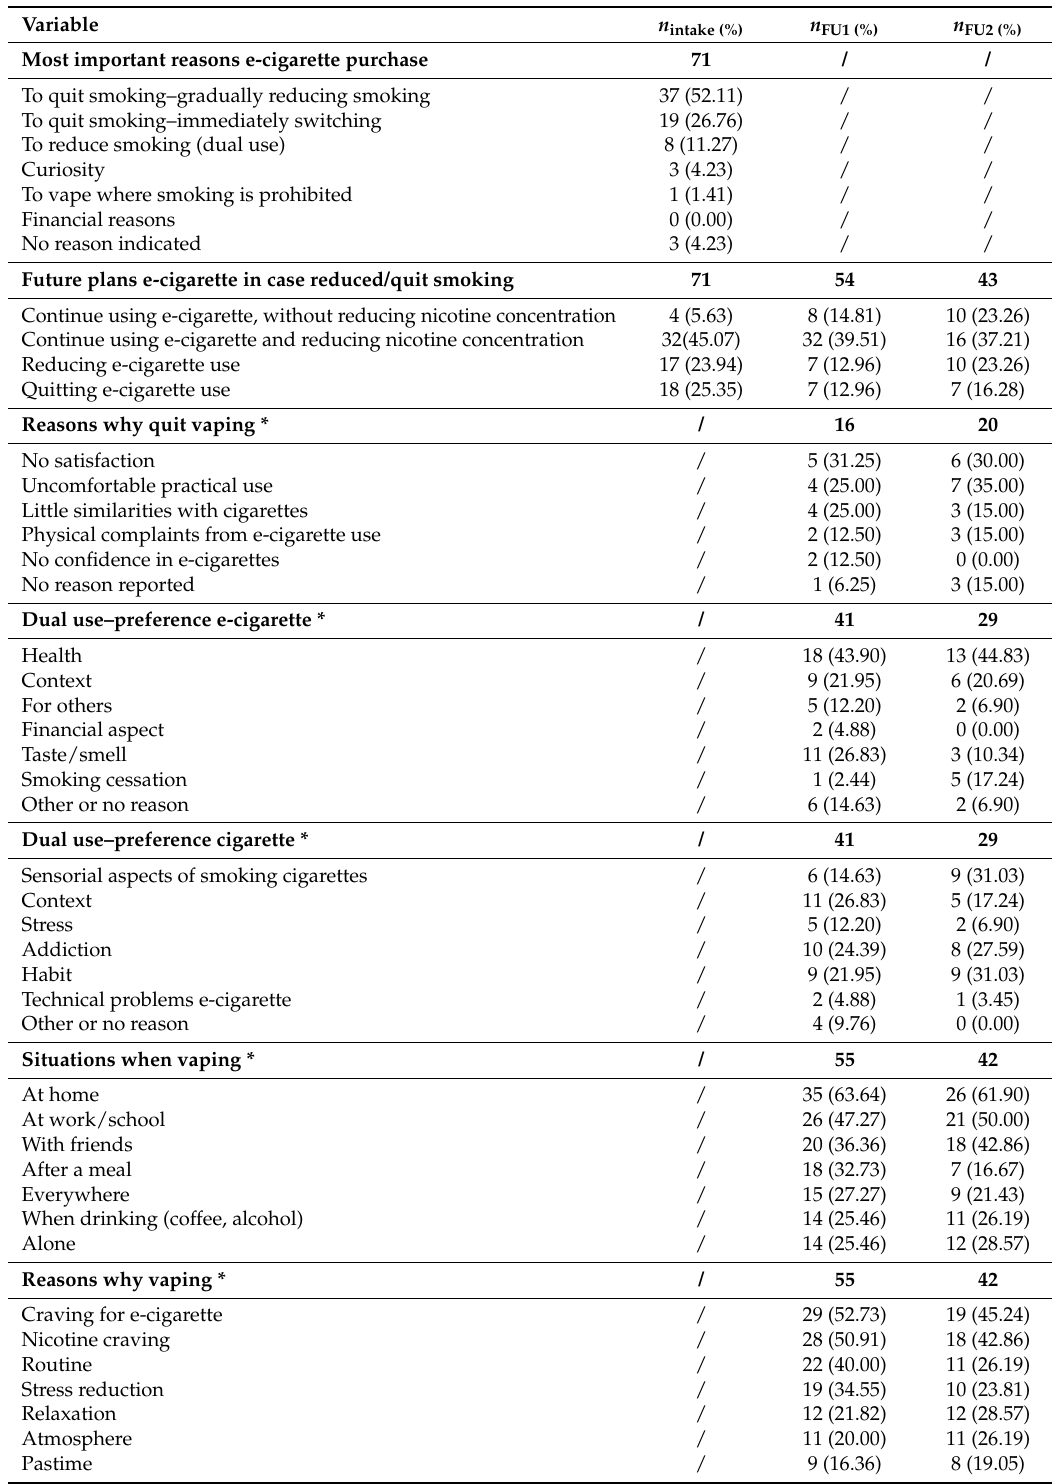
Table 3. E-cigarette profile: most important reason e-cigarette purchase, future plans e-cigarette in case reduced/quit smoking, reasons quit vaping, dual use preference e-cigarette, dual use preference cigarette, situations when vaping and reasons why